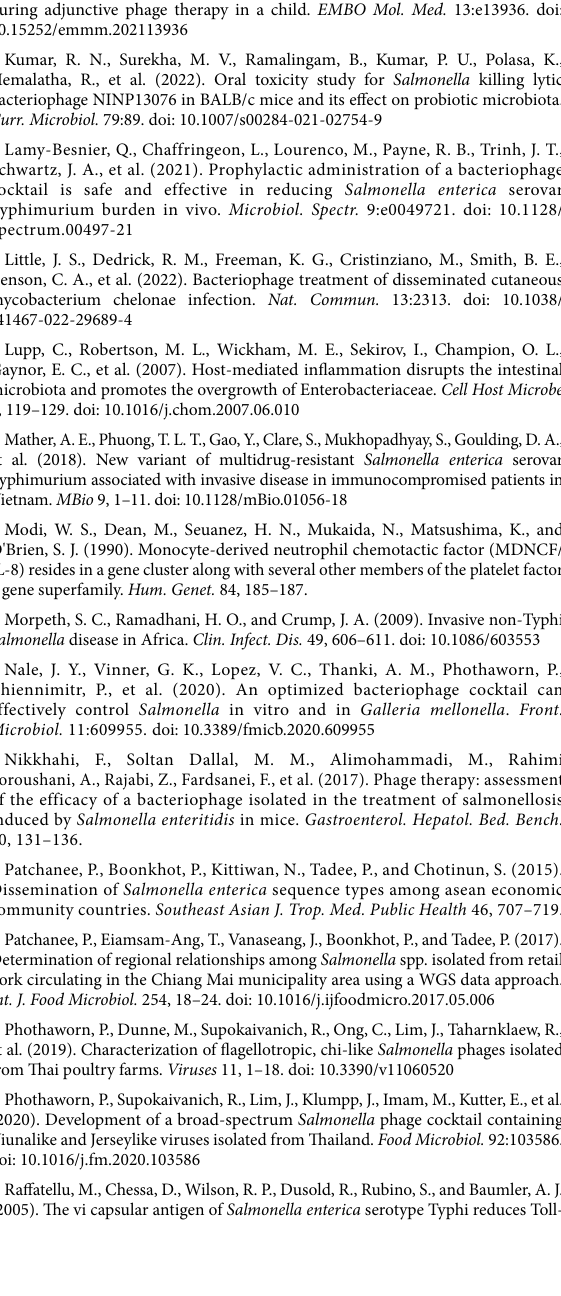
SUPPLEMENTARY TABLE S1 The list of bacterial and phage strains used in this study. SUPPLEMENTARY TABLE S2 The list of primers used in this study. SUPPLEMENTARY TABLE S3 The criteria for mouse cecal histopathological scoring used in this study (Buddhasiri et al.,